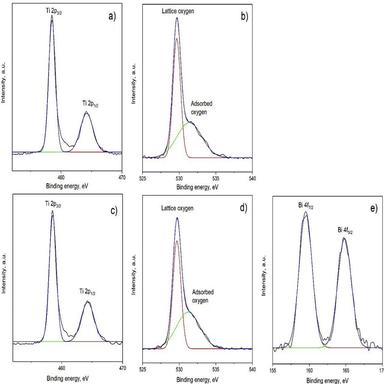
High resolution XPS spectra of P25-based samples: a) Ti 2p spectrum of sample P25; b) O 1 s spectrum of sample P25; c) Ti 2p spectrum of sample P25Bi30; d) O 1 s spectrum of sample P25Bi30; e) Bi 4f spectrum of sample P25Bi30.